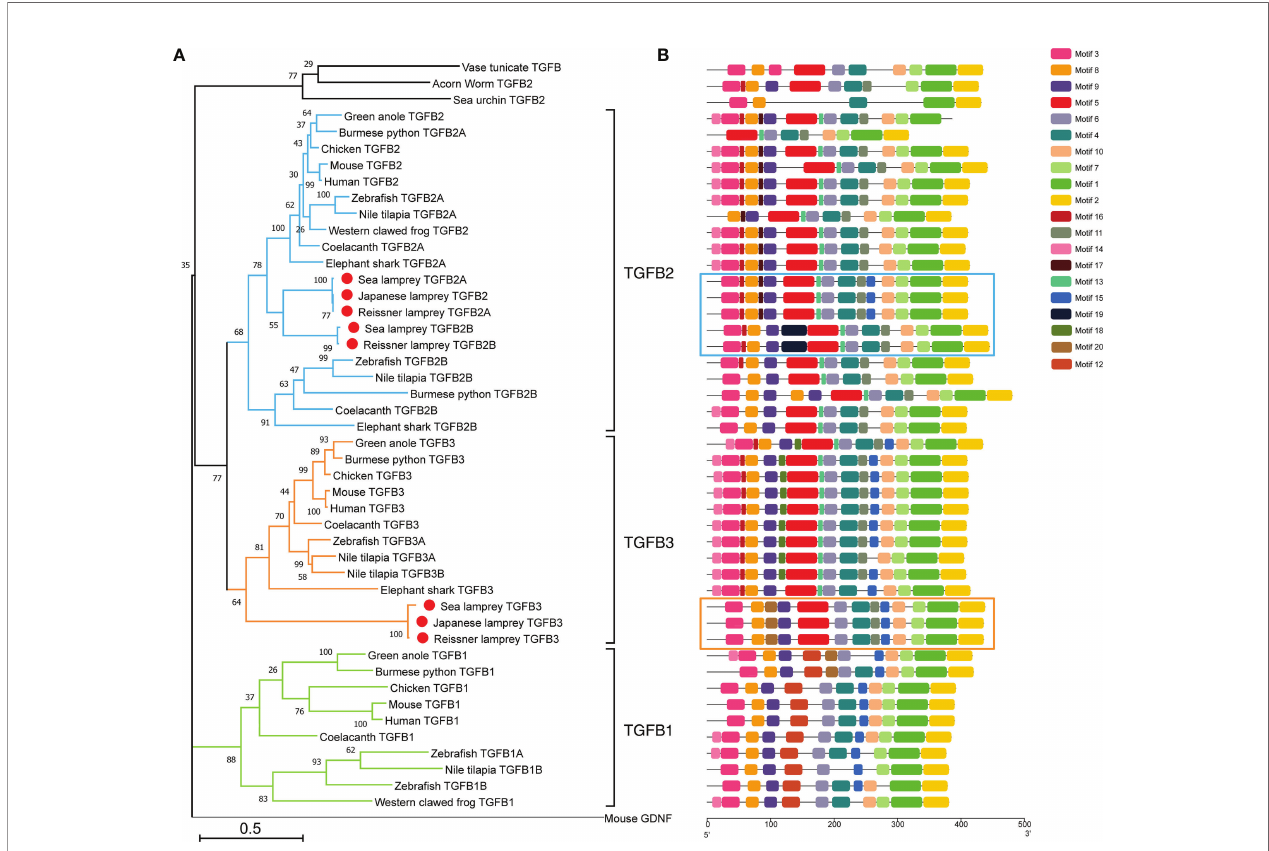
FIGURE 1 | Phylogenetic analysis and conserved motif compositions of TGF- b s in the lamprey and other representative species of the deuterostomes. (A) Phylogenetic tree of TGF- b subfamily members based on the Maximum Likelihood method and JTT matrix-based model. This ML tree consists of 47 full-length amino acid sequences of TGF- b s identi fi ed in lampreys (highlighted with red dots) as well as representative species of the deuterostomes. The tree is drawn to scale, where the bar representing genetic distance is 0.5, and the tree is rooted with the GNDF sequence of mouse ( Mus musculus ). Bootstrap supports in interior branches are shown. The full names of species and the corresponding accession numbers of TGF- b proteins are listed in Supplementary Table 1 . (B) Conserved motifs of TGF- b subfamily members. The motif compositions of all TGF- b s included in the phylogenetic tree are mapped in equal proportion to the number of amino acid residues. Among them, the motifs of fi ve TGF- b 2 homologs in lampreys are highlighted in blue boxes, and the motifs of three TGF- b 3 homologs in lampreys are highlighted in orange boxes. The conserved motifs numbered from 1 to 20 were indicated by different colored boxes, and the matching amino acid sequences in motifs are listed in Supplementary Table 2